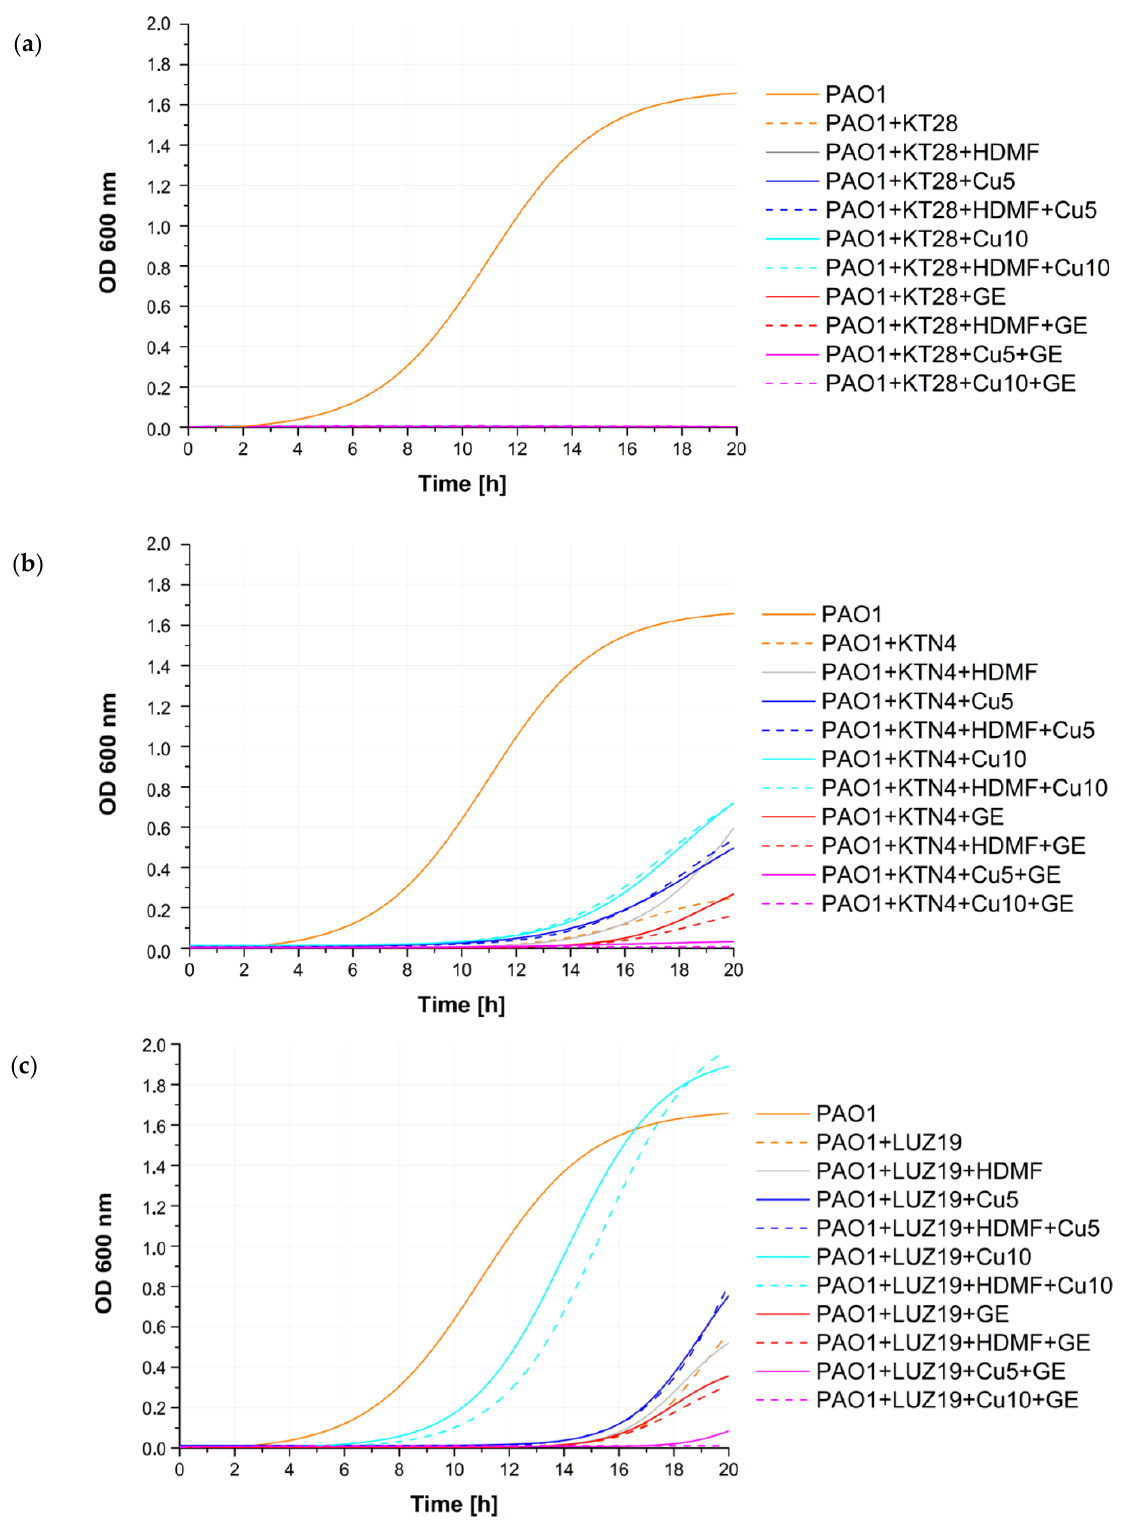
Figure 3. The impact of Cu 2+ , GE, and HDMF and their combination on the P. aeruginosa PAO1 culture growth when infected with ( a ) KT28, ( b ) KTN4, or ( c ) LUZ19 phages. The control consisted of untreated culture (orange solid curve). Fitted curves were established on the average of triplicate OD 600 measurement and the SD in the range +/ − 0–0.3. The kinetics were measured at 20 min intervals.